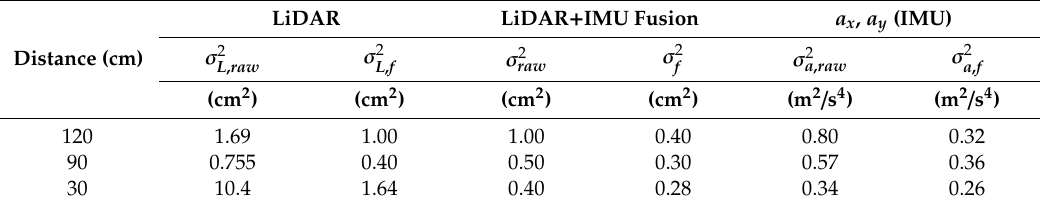
Table 1. Variances of raw and filtered LiDAR and IMU data ( x - and y -components of accelerations, and double-integrated z -component, fused with LiDAR